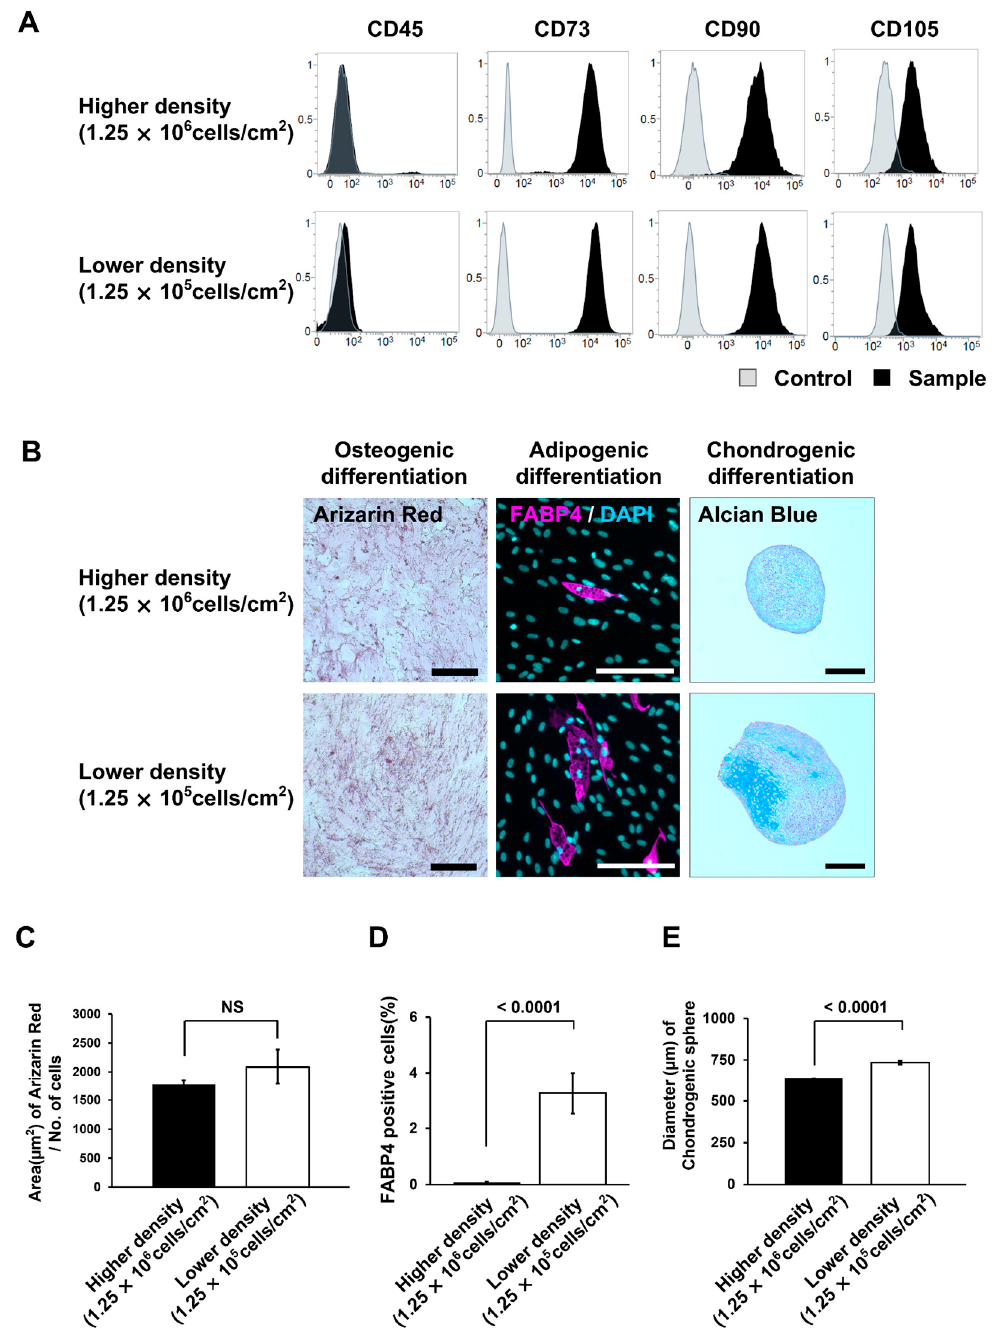
Figure 6. Comparison of surface antigens and differentiation potential of mesenchymal stem cells (MSCs) isolated at higher (1.25 × 10 6 cells/cm 2 ) and lower (1.25 × 10 5 cells/cm 2 ) seeding densities of mononuclear cells (MNCs). ( A ) Data for CD45, CD73, CD90, and CD105 surface antigens using fluorescence-activated cell sorting (FACS) analysis of cells (passage 2). ( B ) Images of induced differentiation of cells into osteocytes, adipocytes, and chondrocytes. The scale bar indicates 200 µm. ( C ) Alizarin-red-stained area of cells induced to differentiate into osteocytes for 21 d. The error bars indicate S.E. ( n = 5). ( D ) Percentage of fatty-acid-binding protein (FABP)-positive cells induced to differentiate into adipocytes for 21 d. The error bars indicate S.E. ( n = 15). ( E ) Size of spheres induced to differentiate into chondrocytes for 21 d. The error bars indicate S.E. ( n = 6). p -values were calculated using a Student’s t -test. NS indicates not significant.